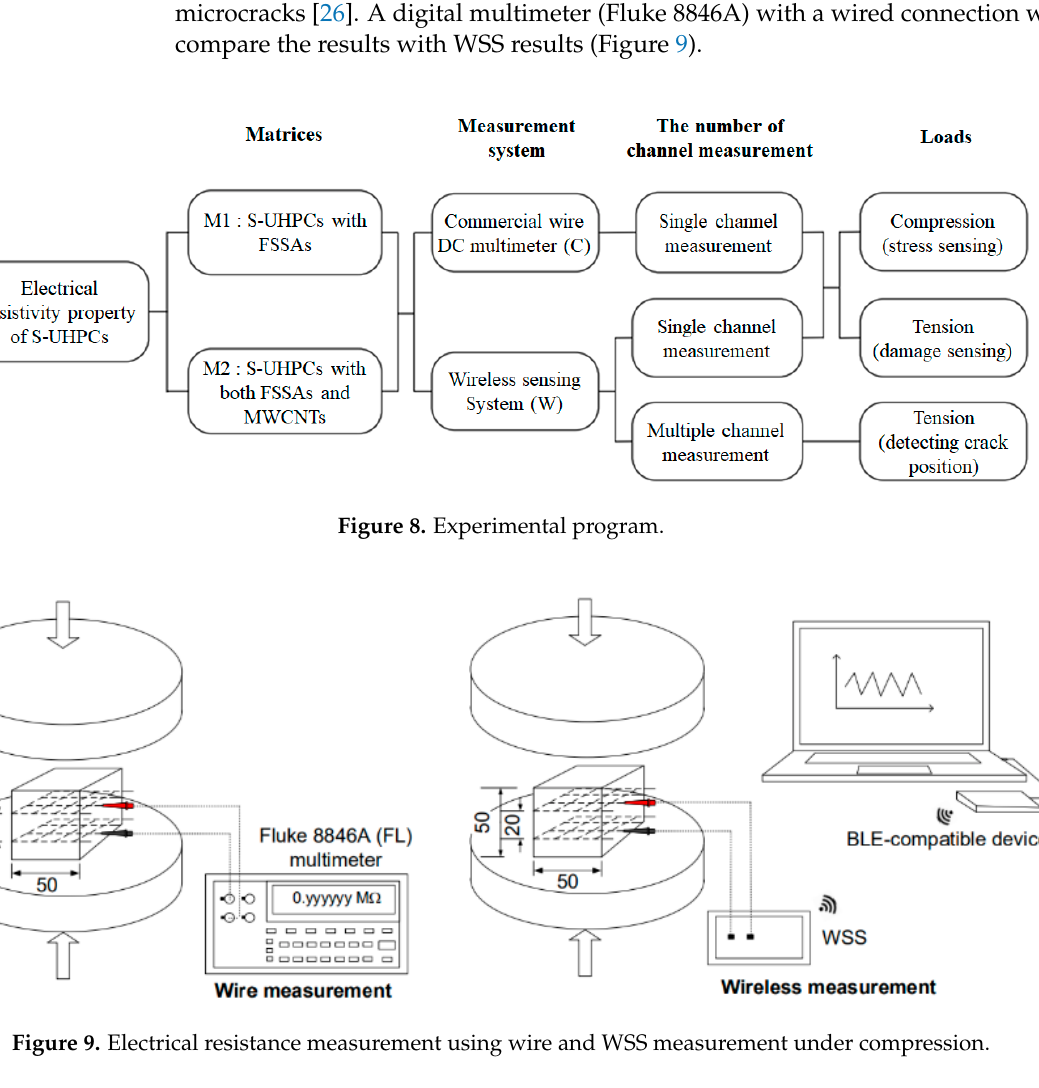
Figure 9. Electrical resistance measurement using wire and WSS measurement under compression.